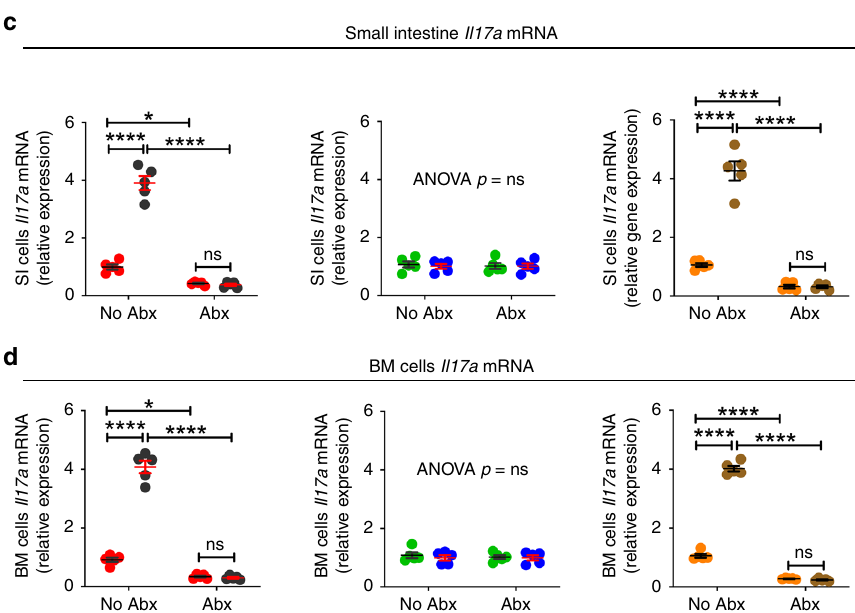
Fig. 4 SFB + microbiota is suf fi cient for cPTH to expand intestinal and BM Th17 cells. a Relative frequency of PP Th17 cells, n = 9 – 10 mice per group. b Absolute number of BM Th17 cells, n = 9 – 10 mice per group. c Small Intestine levels of Il17a transcripts, n = 5 mice per group. d BM levels of Il17a transcripts, n = 5 mice per group. SFB + TAC and JAX mice and SFB − JAX mice were treated with cPTH with antibiotics (Abx) or without antibiotics (No Abx) for 2 weeks. Data are expressed as Mean± SEM. All data were normally distributed according to the Shapiro-Wilk normality test. Data were analyzed by two-way ANOVA and post hoc tests applying the Bonferroni correction for multiple comparisons. * p < 0.05, ** p < 0.01,*** p < 0.001, and **** p < 0.0001 compared to the indicated group. Source data are provided as a Source Data fi